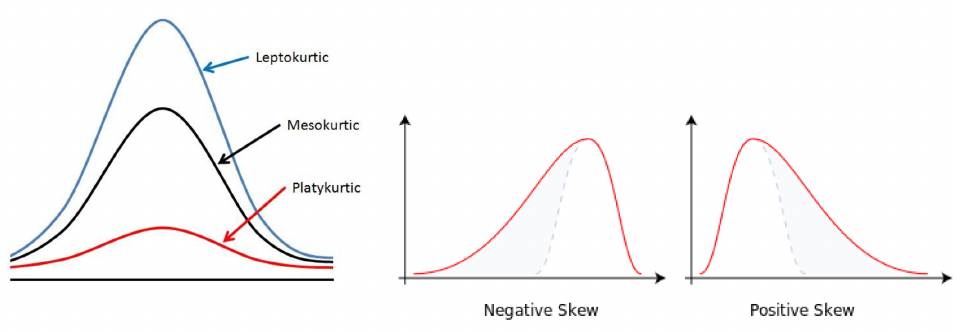
Figure 4. Measures of kurtosis ( left ) [109] and examples of skew in probability distributions ( right )